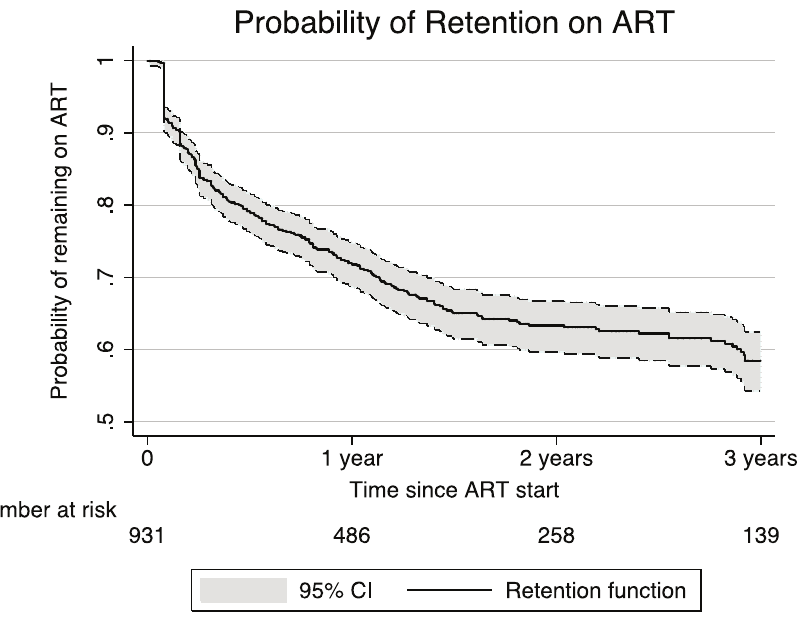
Figure 2. Probability of retention in care for ART patients in Iganga District, Uganda. doi:10.1371/journal.pone.0069433.g002 PLOS ONE |